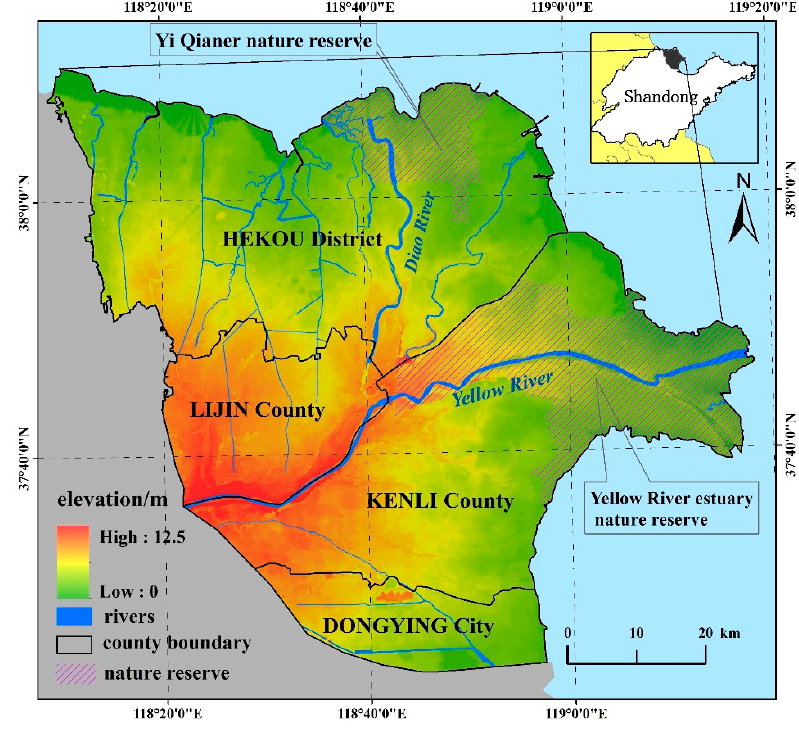
Figure 1. Location and elevation of the study area.